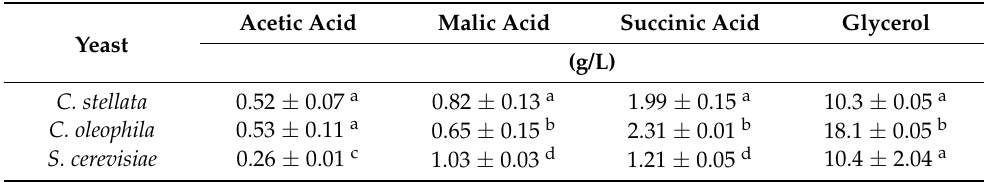
Table 7. Organic acids and glycerol observed in the C. stellata and C. oleophila , and sequential fermentations with S. cerevisiae . Acetic Acid Malic Acid Succinic Acid Glycerol Yeast (g/L) C. stellata 0.52 ± 0.07 a 0.82 ± 0.13 a 1.99 ± 0.15 a 10.3 ± 0.05 a C. oleophila 0.53 ± 0.11 a 0.65 ± 0.15 b 2.31 ± 0.01 b 18.1 ± 0.05 b S. cerevisiae 0.26 ± 0.01 c 1.03 ± 0.03 d 1.21 ± 0.05 d 10.4 ± 2.04